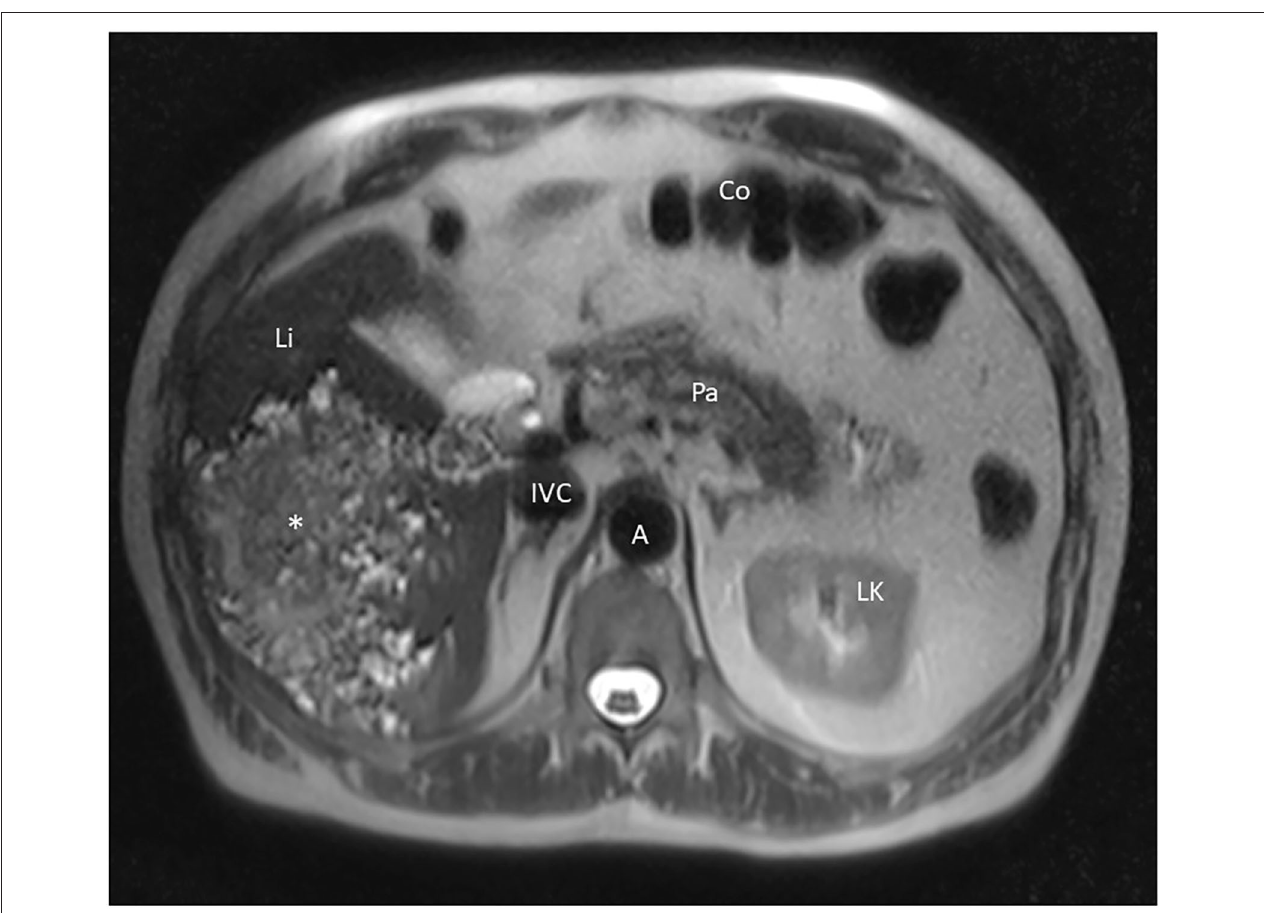
FIGURE 1 | MRI imaging showing the AE lesion of our patient in the axial plane. Li, liver; Co, colon; Pa, pancreas; LK, left kidney; A, aorta; IVC, inferior vena cava, *AE